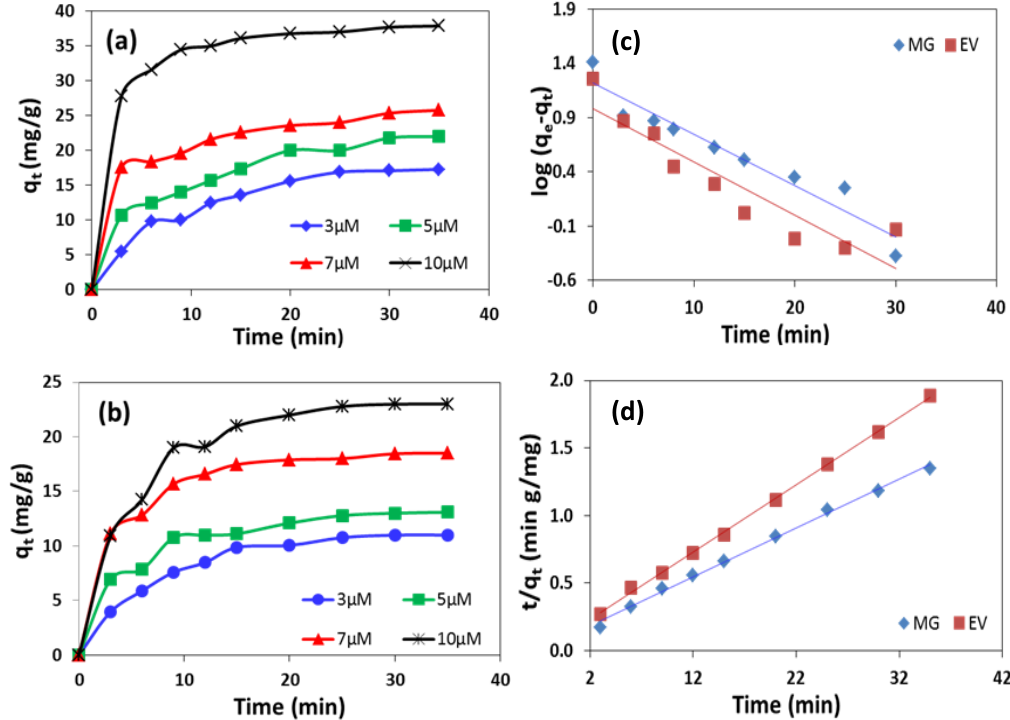
Figure 5. Effect of initial concentration of dyes on the adsorbed amount of ( a ) MG and ( b ) EV on rGO-ZnS nanocomposite at 25 ℃ . Plots of ( c ) pseudo first-order model and ( d ) pseudo second-order model for MG and EV adsorption.